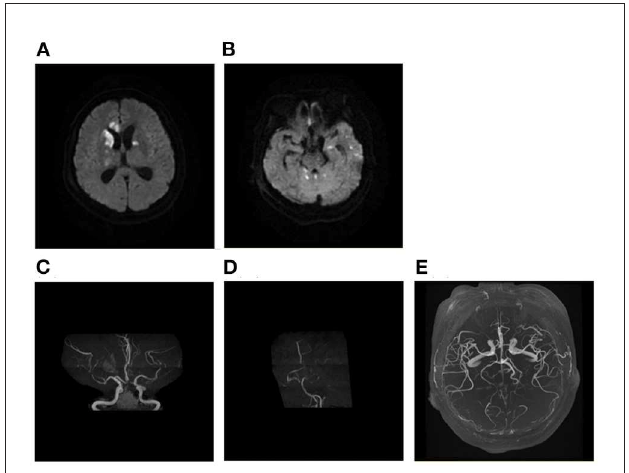
FIGURE7 A case of intracranial infection related AMIMCT. A 62-year-old woman with bacterial meningitis had developed infarcts that involved bilateral basal ganglia, corpus callosum, brainstem, and cerebellum (A, B) . The MRA showing new bilateral ACA, MCA, and PCA stenosis (C, D) compared with MRA performed prior to 1 month (E) . AMIMCT, acute multiple infarcts in multiple cerebral territories; MRA, magnetic resonance angiograph; ACA, anterior cerebral artery; MCA, middle cerebral artery.